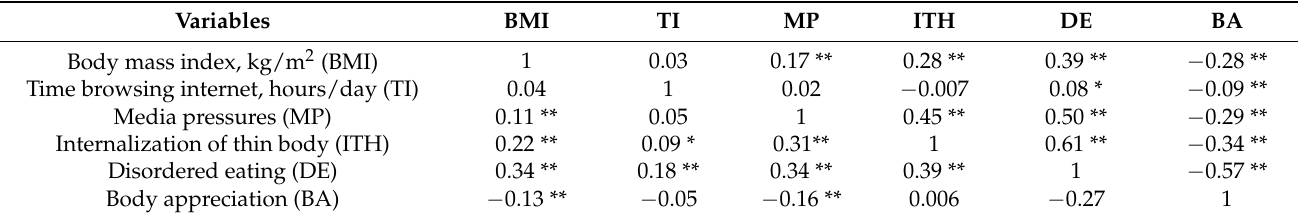
Table 2. Correlations between study variables ( n = 1412).